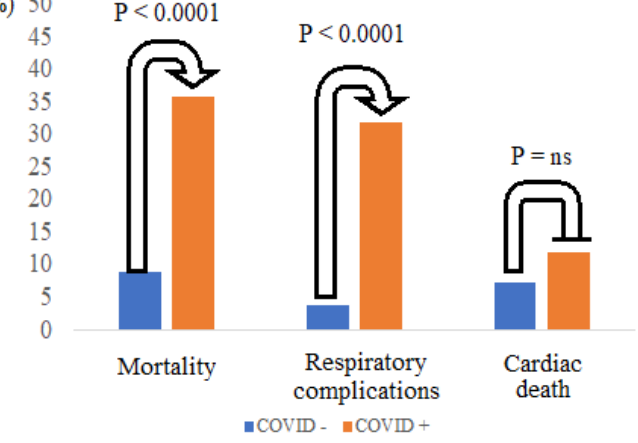
Figure 1. In-hospital mortality according to cardiac death and COVID-19 infection.